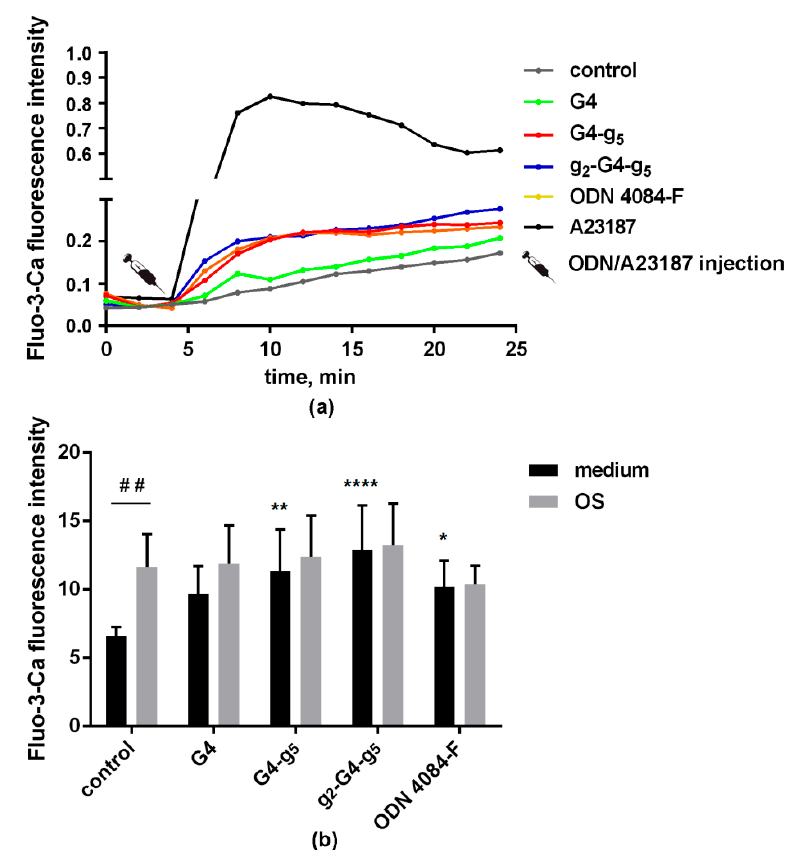
Figure 4. Impact of ODNs on an increase in the concentration of free calcium ions in the cytosol of neutrophils. ( a ) Kinetic profiles of cytosolic calcium ions concentrations. Fluo-3 AM loaded PMNLs (0.5 × 10 6 / mL) were incubated without (control) or with 1 µ M oligonucleotides for 20 min. During this time, the changes in calcium ion level were recorded by fluorescence spectrometry as described. Calcium ionophore A23187 (1 µ M) was used as positive control. Each trace is the average of three scans. ( b ) Presented are pooled flow cytometry data (the means ± SEM) of calcium bound Fluo-3 fluorescence intensities (arbitrary units) (n = 6). PMNLs (1 × 10 6 / mL) were incubated with 1 µ M oligonucleotides for 20 min with or without the addition of opsonized S . typhimurium (OS) for the last 10 min of incubation. Immediately after the reaction was stopped by cooling, fluorescence (upon excitation of 488 nm and emission of 525 nm) was measured by flow cytometry. * p < 0.05; ** p < 0.01; **** p < 0.001 compared to the control probe without ODN, ## p < 0.01 for the pair of data specified, as indicated by two-way ANOVA followed by Sidak’s multiple comparison test.